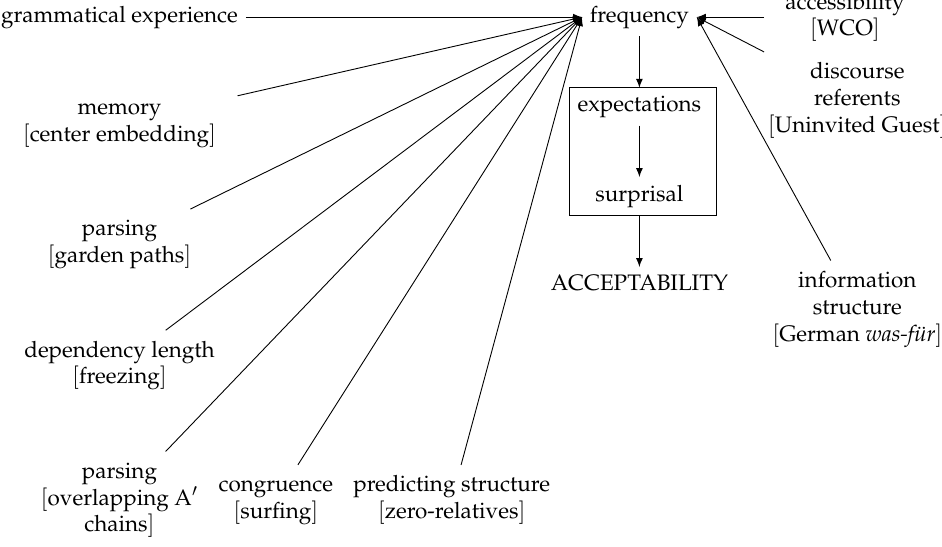
Figure 11. The logic of acceptability judgments for grammatical conditions, final